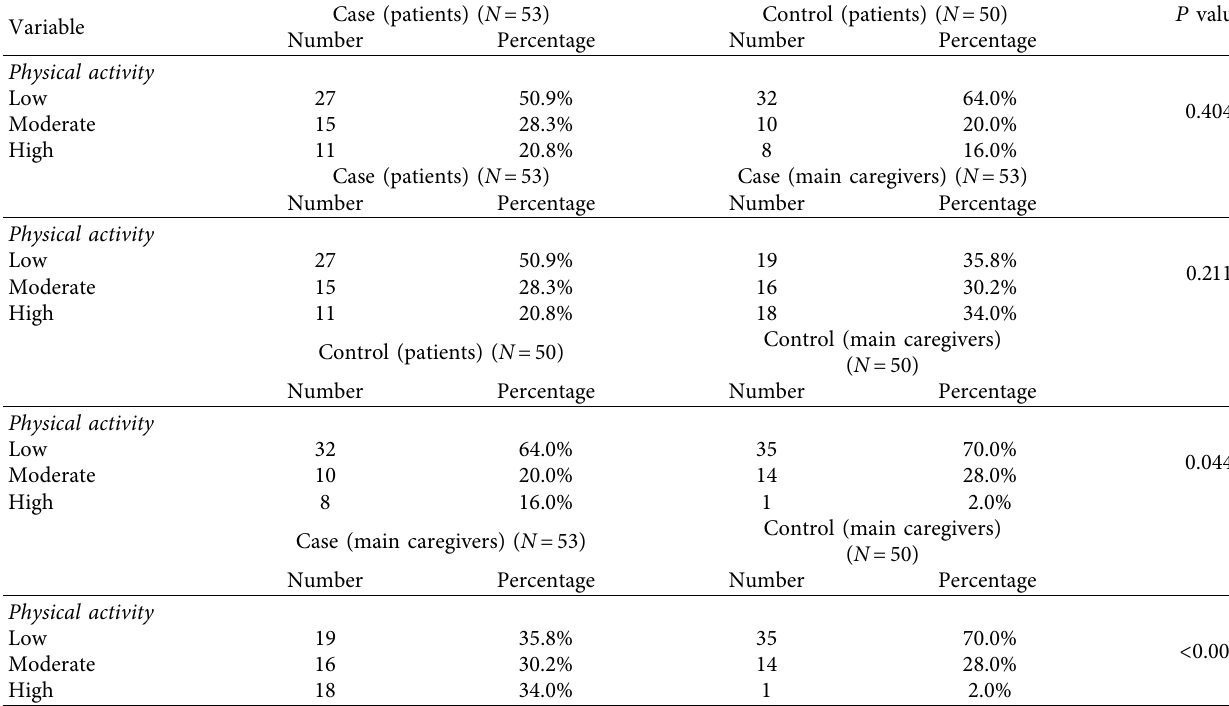
Table 3: Physical activity.